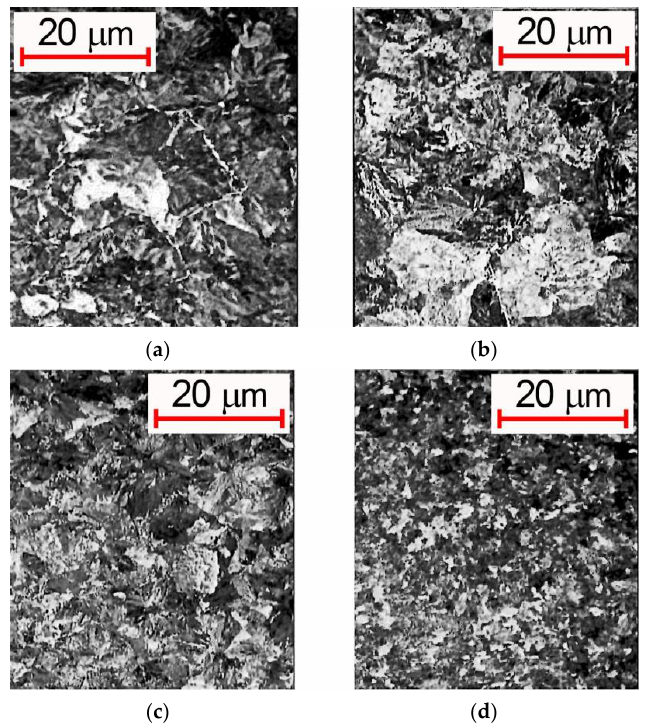
Figure 5. Microstructure of the rail head metal (E76HGF) welded by continuous melting where ( a ) welded joint; ( b ) partial melting zone; ( c ) zone of forming the eutectoid mixture of pearlite and cementite after overheating; ( d ) zone of forming the eutectoid mixture of pearlite and cementite without overheating.